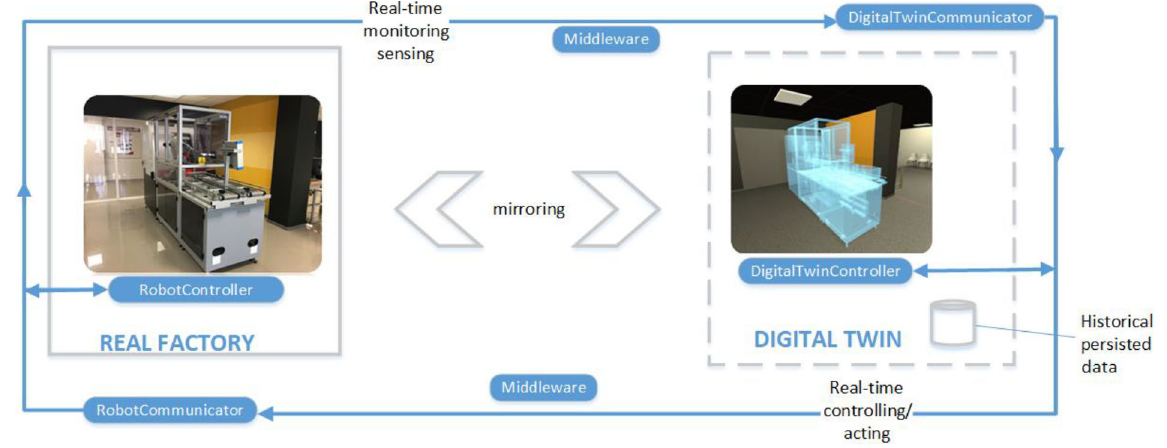
Fig. 2. Synchronization process through the proposed software